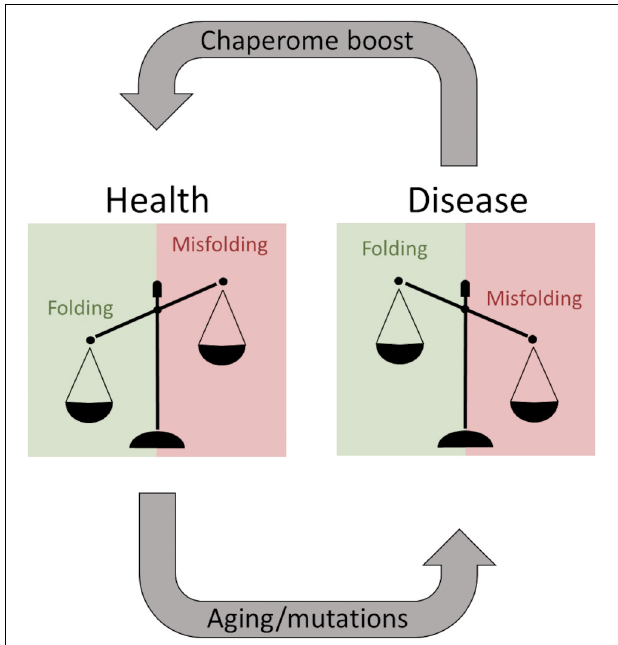
FIGURE 10 | The balancing act of proteostasis. As long as chaperones efficiently keep proteins from misfolding a patient remains healthy. Aging and predisposing mutations facilitate protein misfolding shifting the balance and overwhelming the chaperome, resulting in degenerative diseases. These systems are potentially druggable to boost the chaperome to exacerbate the healthy situation during aging, and theoretically, this can be a therapeutic strategy even after disease